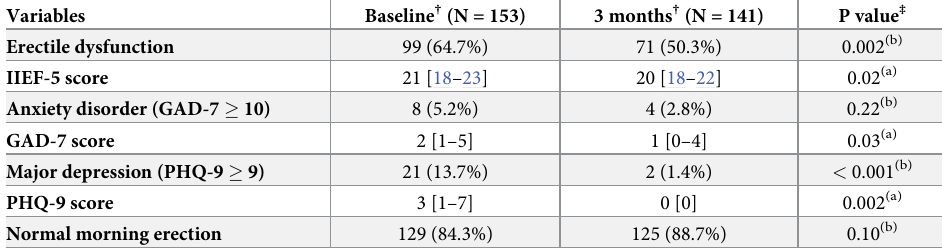
Table 2. Temporal changes in erectile function and mental health status at baseline and three months after COVID-19 recovery (N = 141).